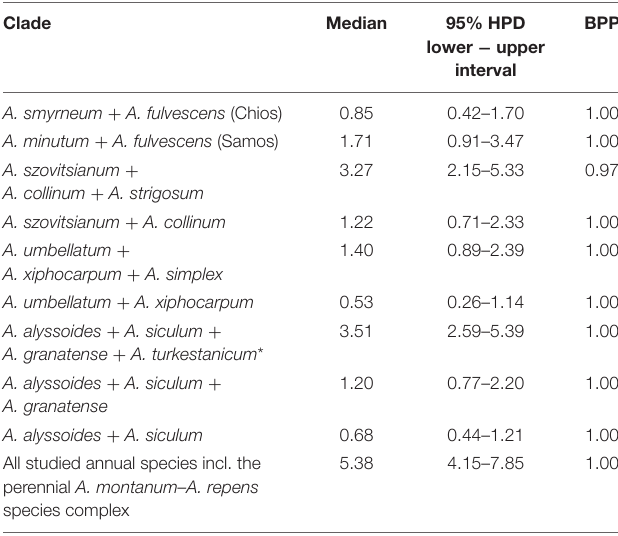
TABLE 4 | Age estimates (median and 95% of the highest posterior density, HPD) in millions of years for the nodes of the given clades of the studied Alyssum species, as inferred from the relaxed molecular-clock analysis, performed in BEAST and based on ITS sequence data (see Supplementary Figure 4 and Supplementary Table 2